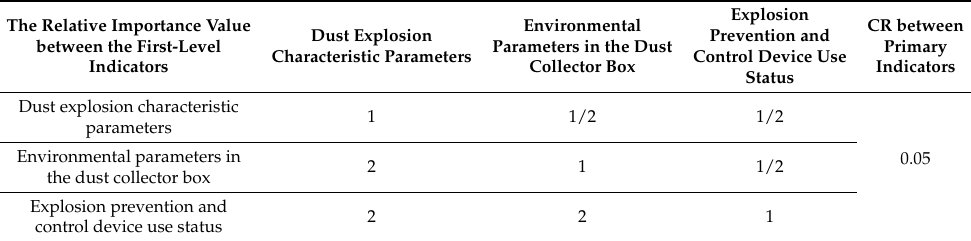
Table 7. Examples of experts’ judgment matrix and consistency test results for the evaluation indicators among the first-level indicators.